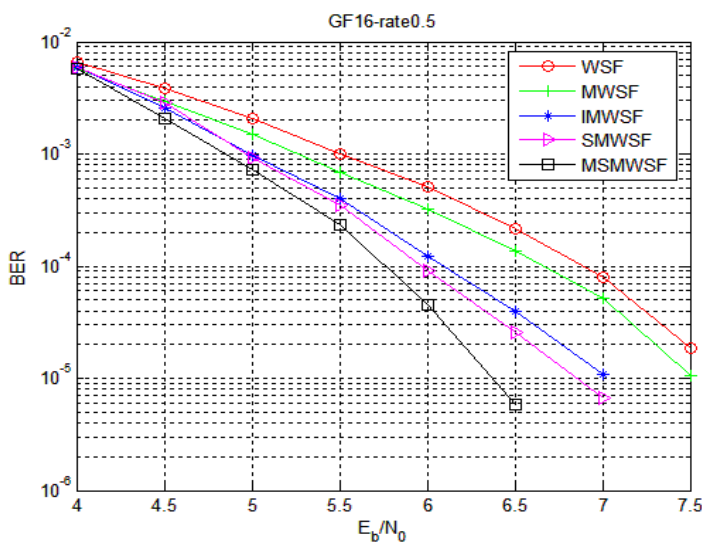
Figure 6. Comparison of five algorithms under Code 2.